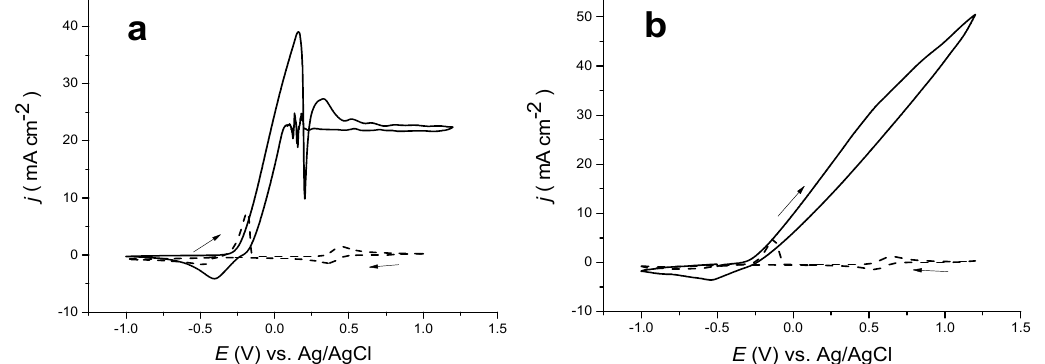
Figure 1. Cyclic voltammetric responses of a Cu disc (solid line) and 0.1 M CuCl 2 · 2H 2 O (dashed line) in choline chloride-based ionic liquid (IL) on a platinum electrode at 20 ◦ C ( a ), and a Cu disc (solid line) and 0.2 M CuCl 2 · 2H 2 O in imidazolium-based IL (dashed line) at 70 ◦ C ( b ), all at a sweep rate of 5 mV · s − 1 .